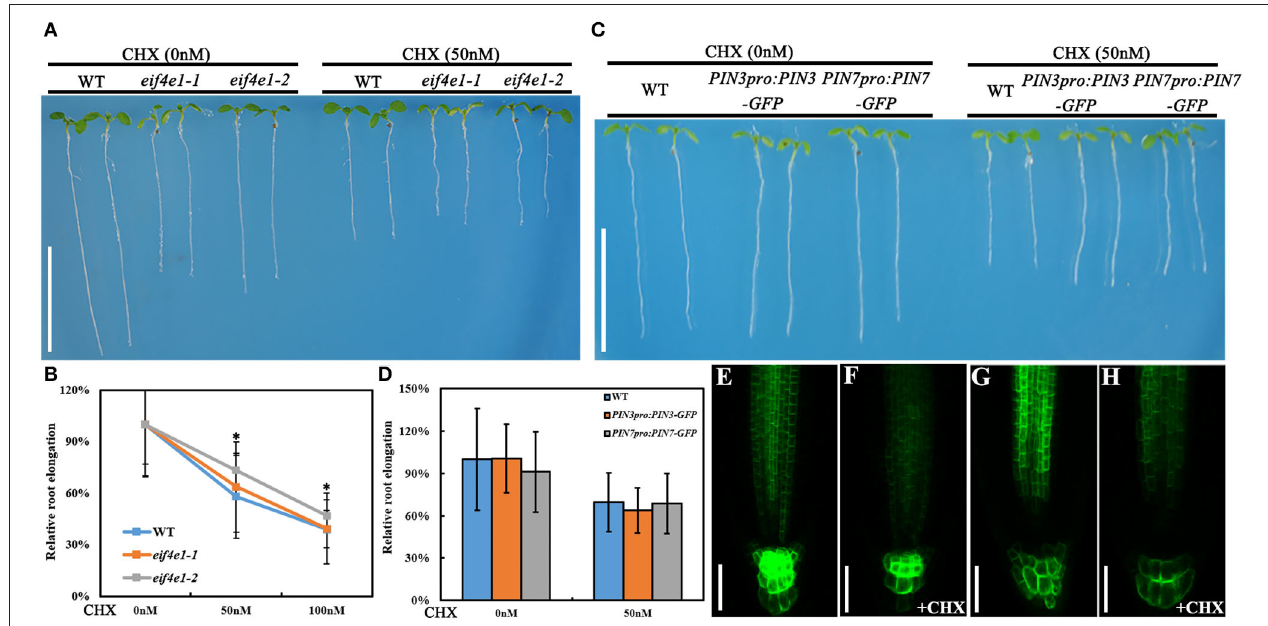
FIGURE 5 | CHX treatment can mimic the eif4e1 phenotypes. (A) CHX treatment inhibits the root elongation. Four-day-old seedlings of wild type, eif4e1-1 , and eif4e1-2 were transferred onto half-strength MS medium with or without 50nM CHX for another 3-day growth. (B) Relative root elongation of wild type, eif4e1-1 , and eif4e1-2 after treated with 50 or 100nM CHX. (C) Four-day-old seedlings of wild type, PIN3 pro :PIN3-GFP , and PIN7 pro :PIN7-GFP were transferred onto half-strength MS medium with or without 50nM CHX for another 3-day growth. (D) Relative root elongation of (C) . (E–H) Confocal images showing the abundance of PIN3 and PIN7 proteins at the root cells of 4-day-old seedlings. Four-day-old seedlings of PIN3 pro :PIN3-GFP and PIN7 pro :PIN7-GFP were treated with (F,H) or without (E,G) CHX for another 3-day growth. The asterisks indicate significant difference by Student’s t test (* P < 0.05). Scale bars: (A,C) 1cm; (E–H) 50 µ